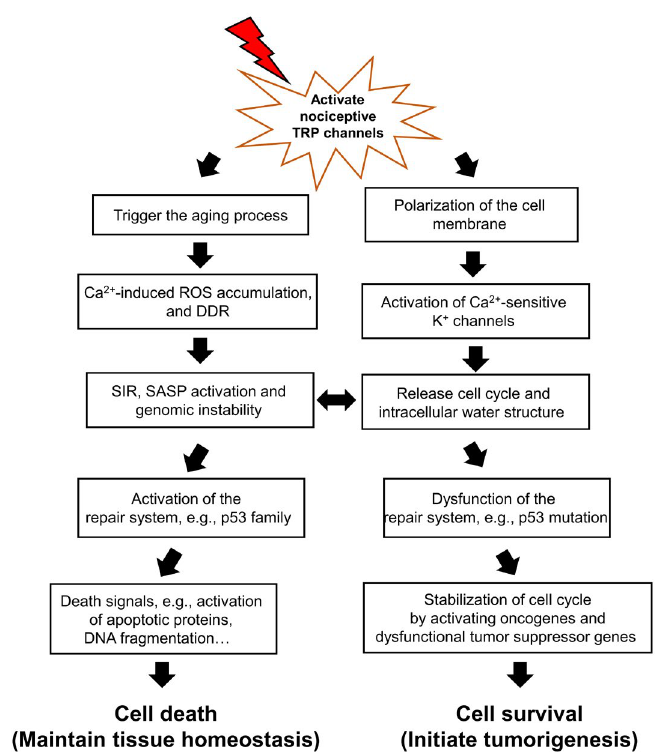
Figure 1. Environmental stimuli-activated nociceptive TRP channels disturb the balance between cell death and survival by high-magnitude Ca 2+ entry. Upon the release of cell cycle arrest by initiating the aging process, the fate of cells is determined: death or survival. The repair system, such as p53 protein family is involved in this determination. When genomic instability cannot be repaired due to dysfunction of the repair system, the release of cell cycle arrest in senescent cells results in tumorigenesis, because senescent cells don’t progress to cell death. Senescent cells could initiate the cell cycle through Ca 2+ -activated K + channels which are activated by nociceptive TRP channels, and stabilize the released-cell cycle with activation of oncogenes and dysfunction of tumor suppressor genes. On the other hand, in the aging process, nearly all cells face ROS released from mitochondria and DDR and SIR, and if the p53 protein family is activated, eventually contribute to cell death. Environmental stimuli-activated nociceptive TRP channels initially result in increased Ca 2+ entry to activate death signals